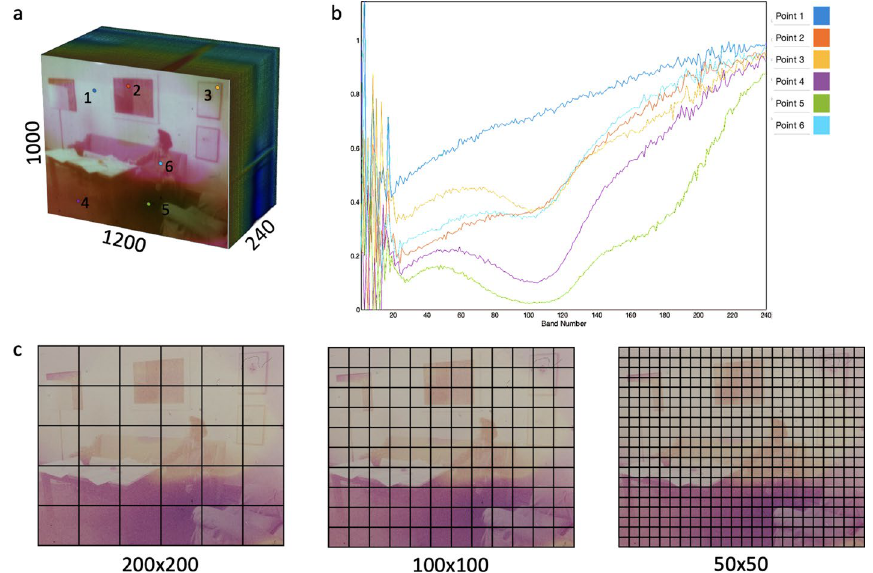
Fig. 2 Pre-processing phases of the hypercubes: a Illustration of the hypercube in region of interest, after cropping and binning. b comparison of spectra extracted from the hypercube, on which indicated the locations of the selected points. c Schematic representation of the grids evaluated: 200 and